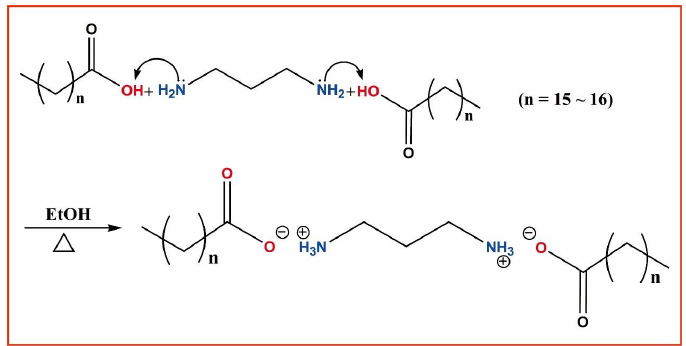
Figure 15. Schematic diagram of the synthesis of the two molecules: where ( a ) represents 3C16 and ( b ) represents 3C17.